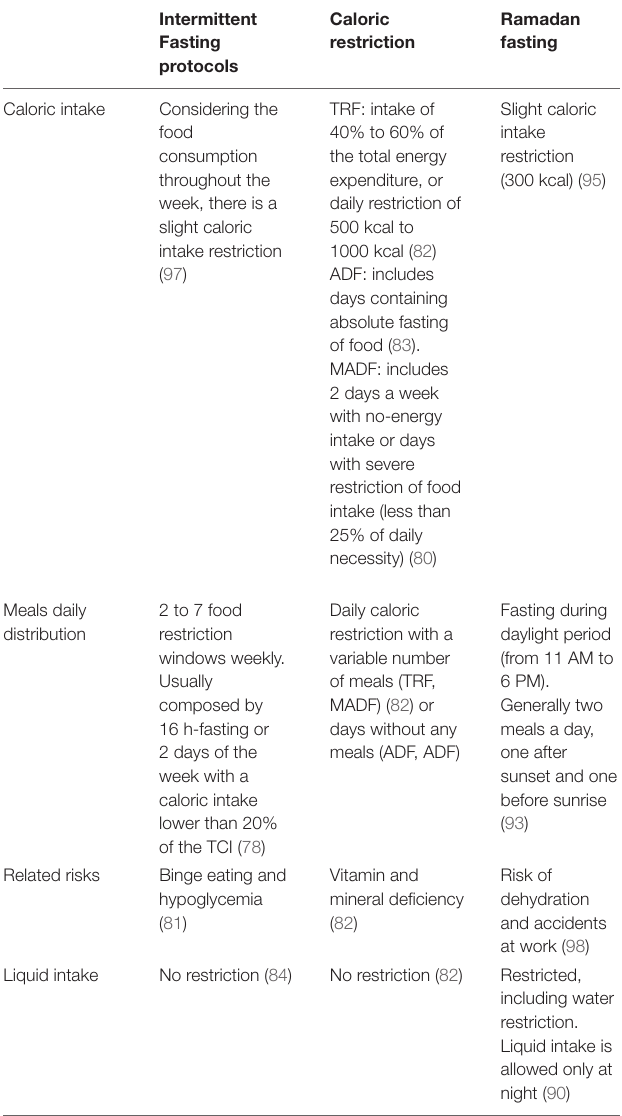
TABLE 2 | Main differences between intermittent fasting, caloric restriction, and Ramadan